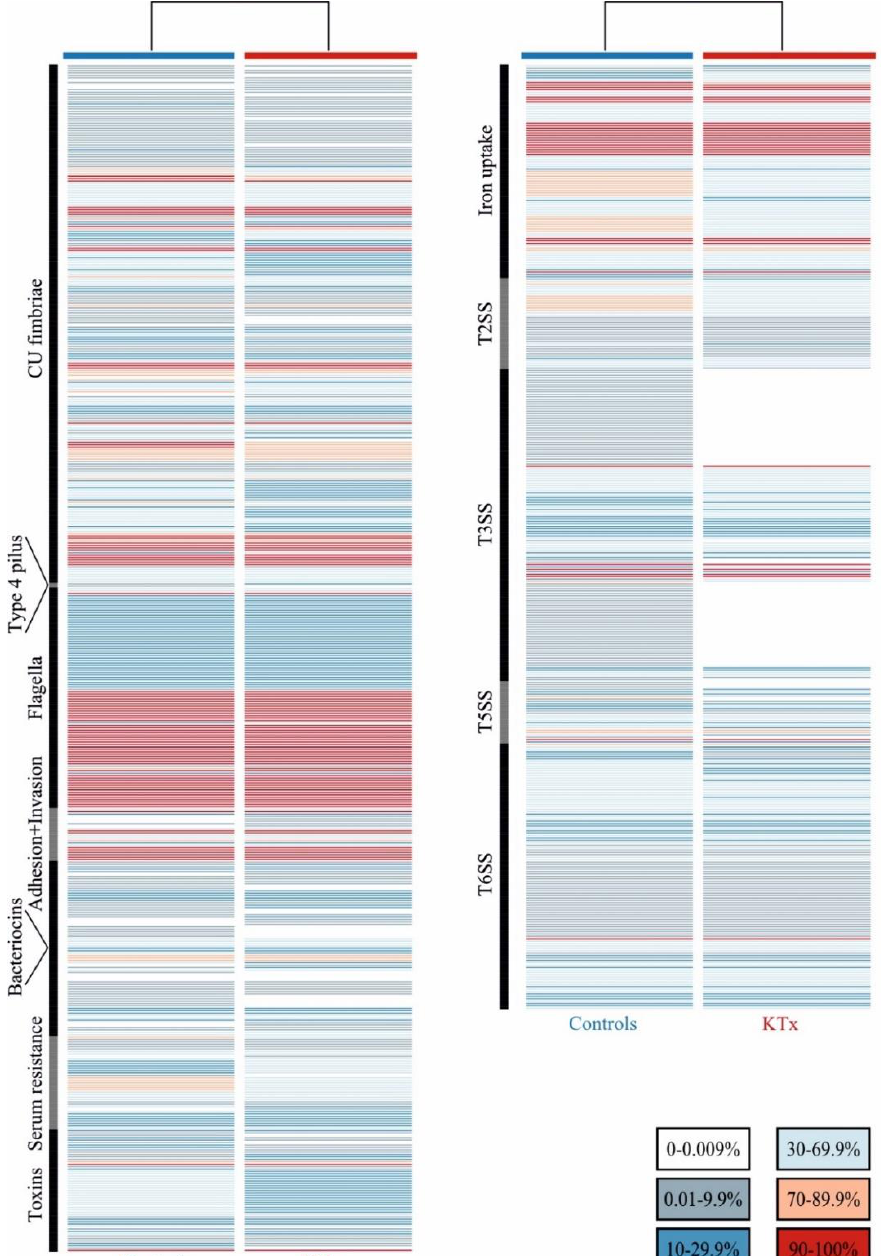
Figure 2. Heatmap displaying the distribution of virulence factors present in KTx and control UPEC isolates. Each row represents one virulence factor. The prevalence of each virulence factor (VF) in KTx and control strains is coded by a color gradient. Vertical black and grey bars indicate the functional VF group: CU-fimbriae = chaperone-usher fimbriae, T2SS = type 2 secretion system, T3SS = type 3 secretion system, T5SS = type 5 secretion system, T6SS = type 2 secretion system. The color code indicates the prevalence of the corresponding VF (calculated as percentage) in the KTx and control group, respectively.